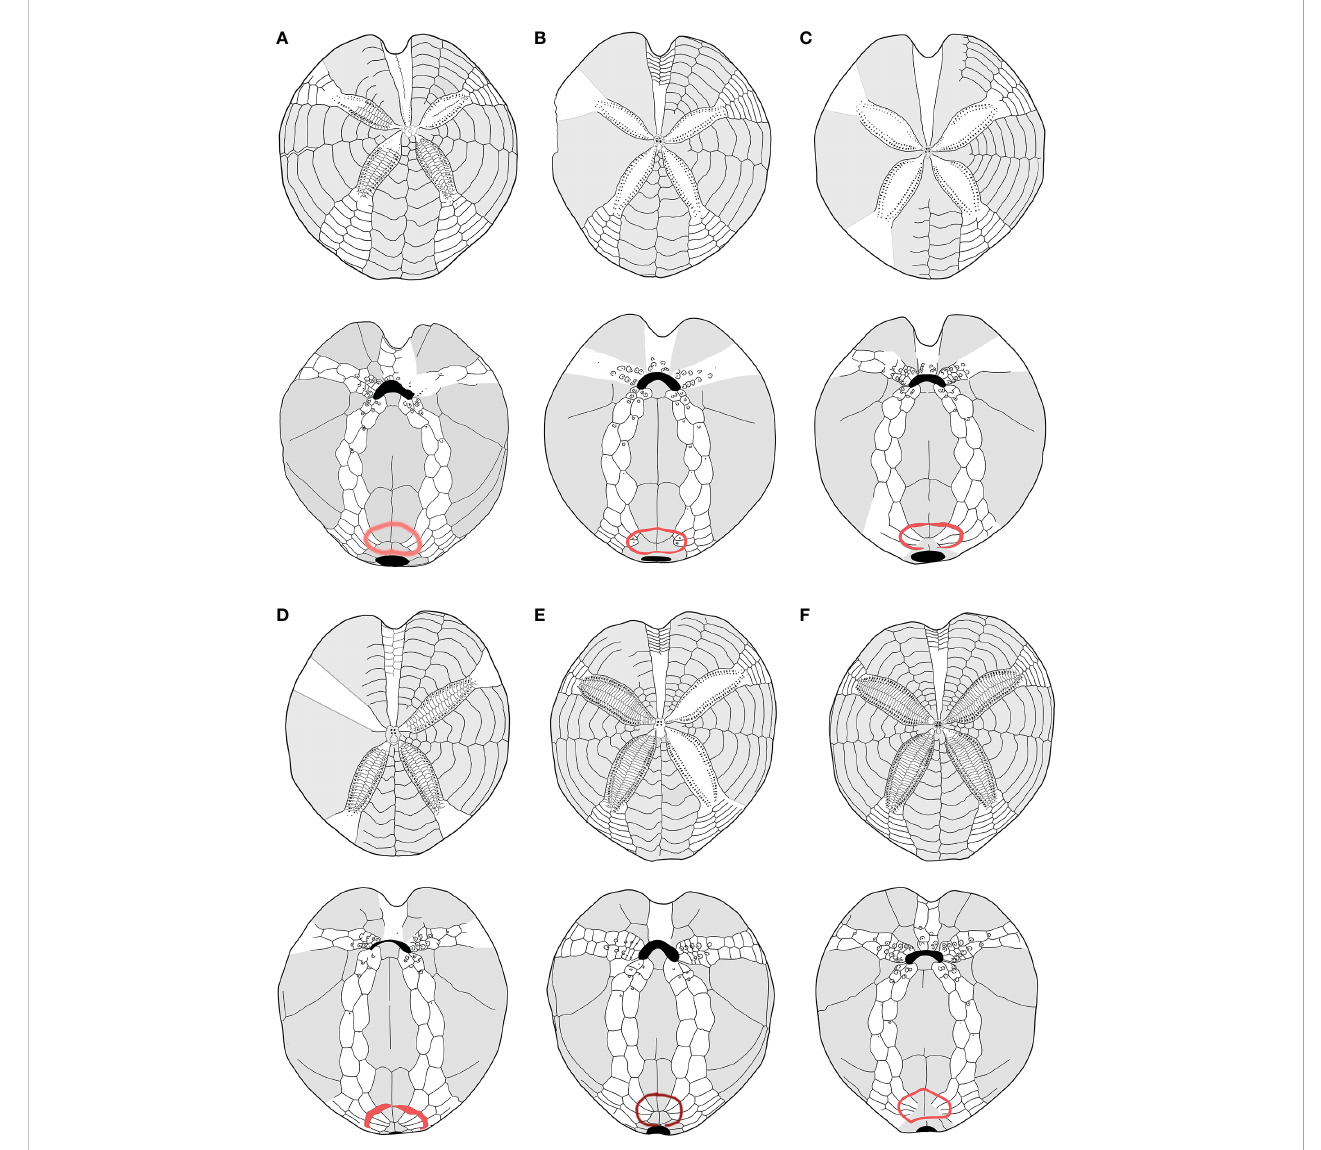
FIGURE 5 (A – F) Structural similarities in aboral (up) oral and oral (down) schemes, between recent and fossil species of Propespatagu s analyzed in this work: (A) Propespatagus subinermis , Pliocene di Otranto, Lecce, Puglia (Italy); (B) Propespatagus inermis , Gulf of Naples, Mediterranean (redrawn